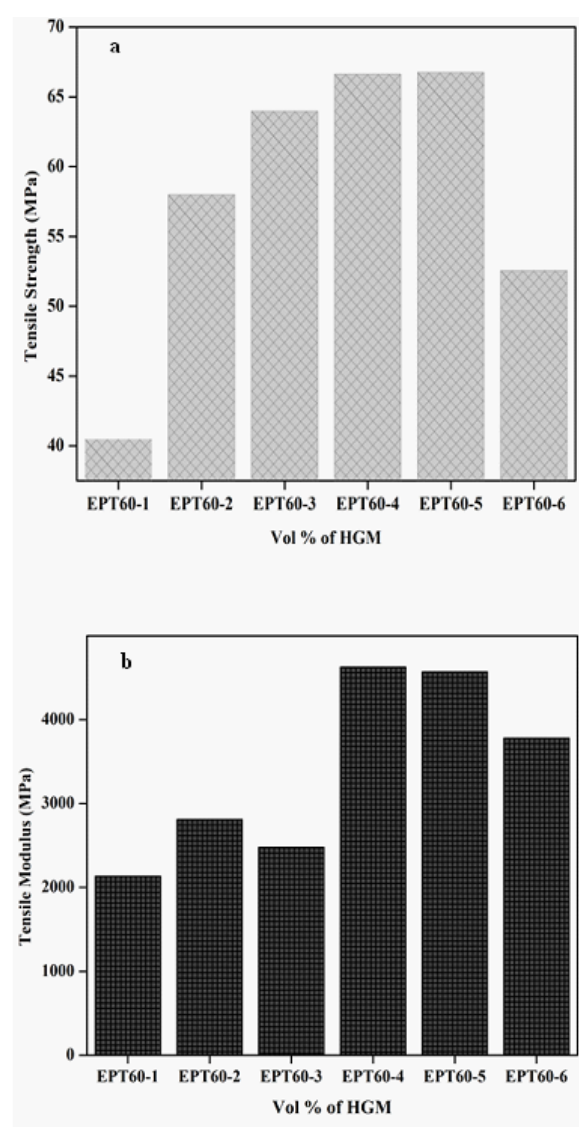
Figure 3: a) Tensile strength relationship between the neat epoxy resin and EPT60 syntactic foam and b) Tensile modulus relationship between the neat epoxy resin and EPT60 syntactic foam.